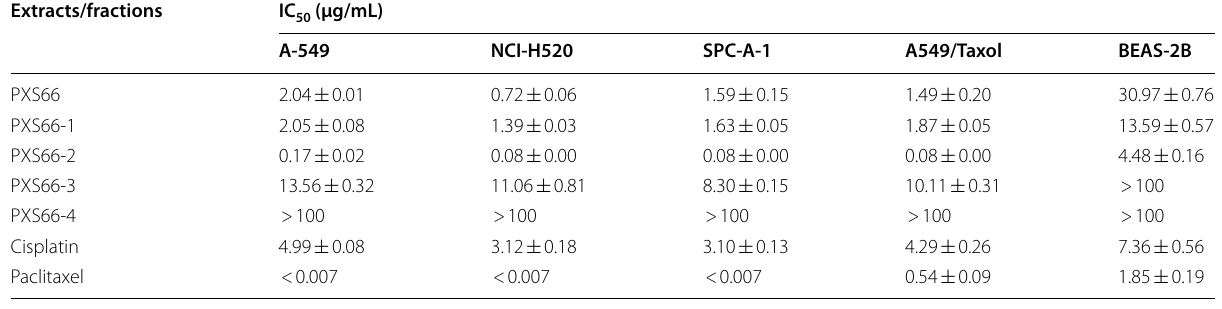
Table 2 Cytotoxicity of the EtOH extract (PXS66) and petroleum ether‑soluble (PXS66‑1), EtOAc‑soluble (PXS66‑2), n ‑BuOH‑soluble (PXS66‑3), and H O‑soluble (PSX66‑4) fractions 2 Extracts/fractions